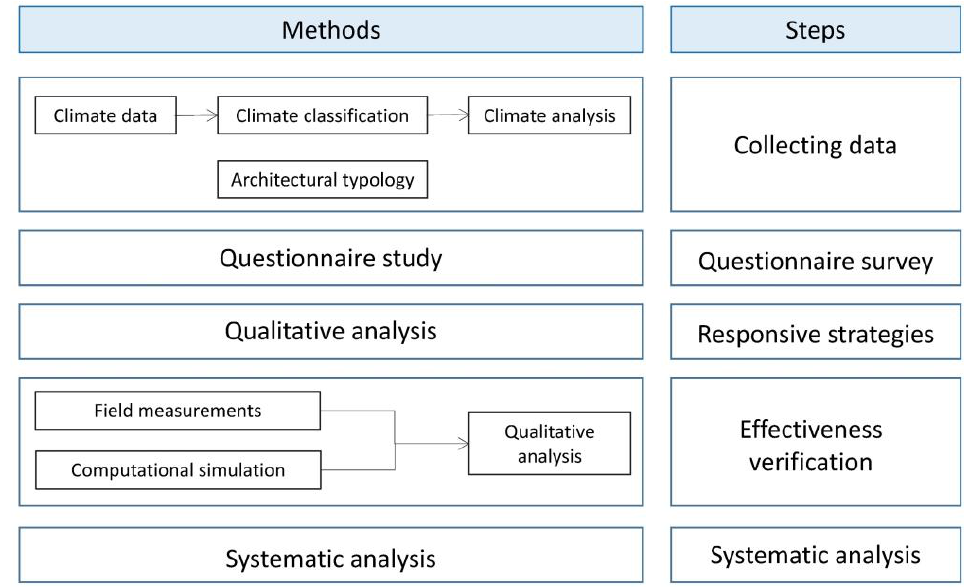
Figure 1. Research process of the studies on climate-responsive design (Adapted with permission from [42]. 2022, Elsevier).